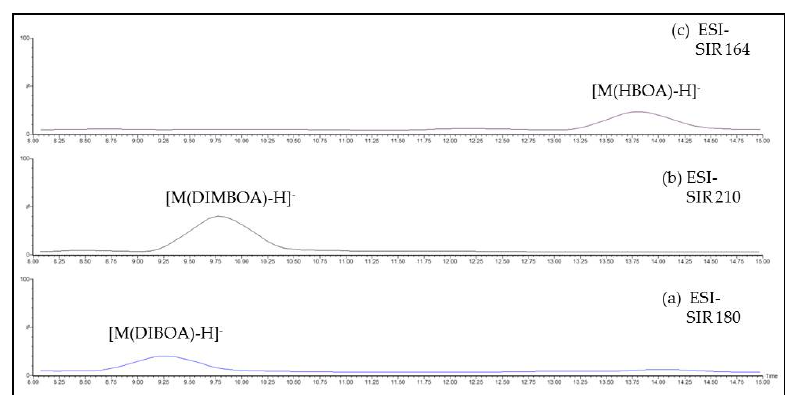
Figure 4. ESI- SIR channels at (a) 180, (b) 210 and (c) 164 m/z , corresponding to the ion [M-H] − of (a) DIBOA, (b) DIMBOA and (c) HBOA, respectively. AR3 herbal tea as an example.